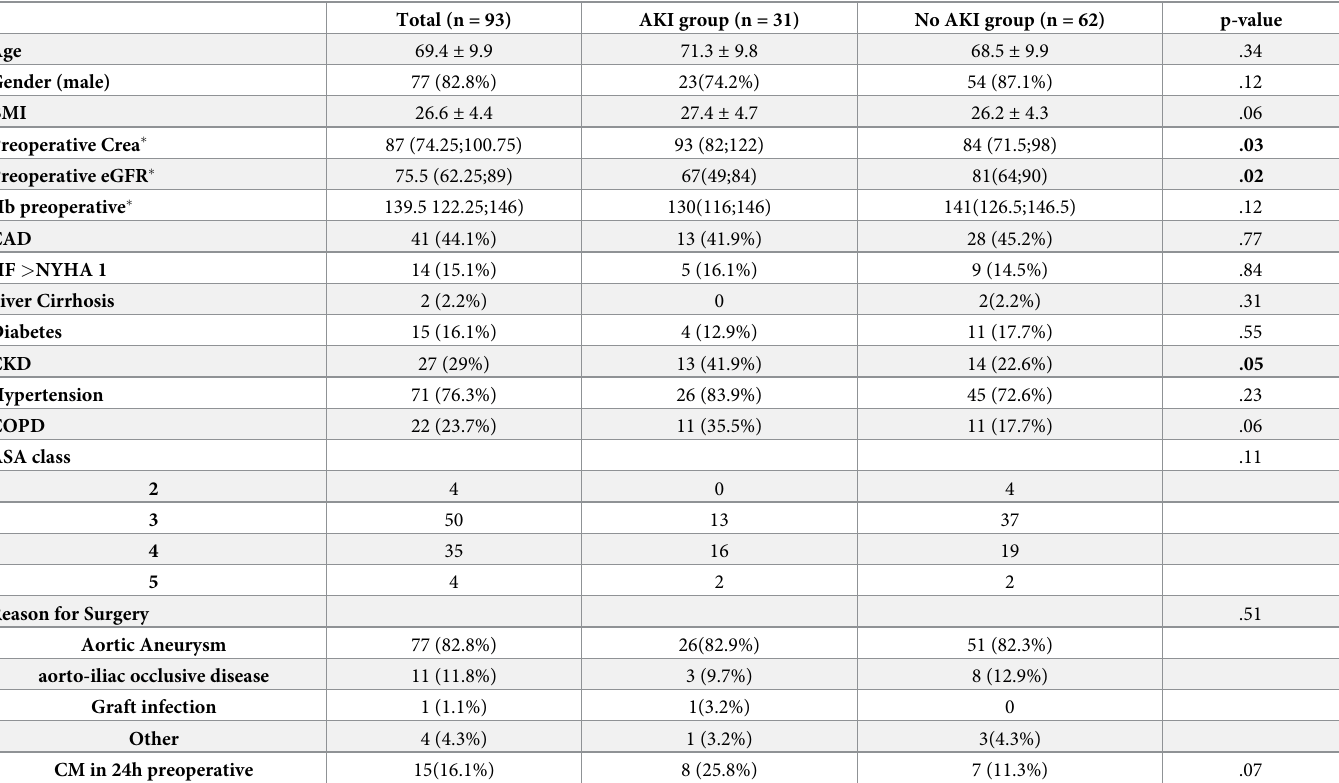
Table 1. Baseline demographics and variables.